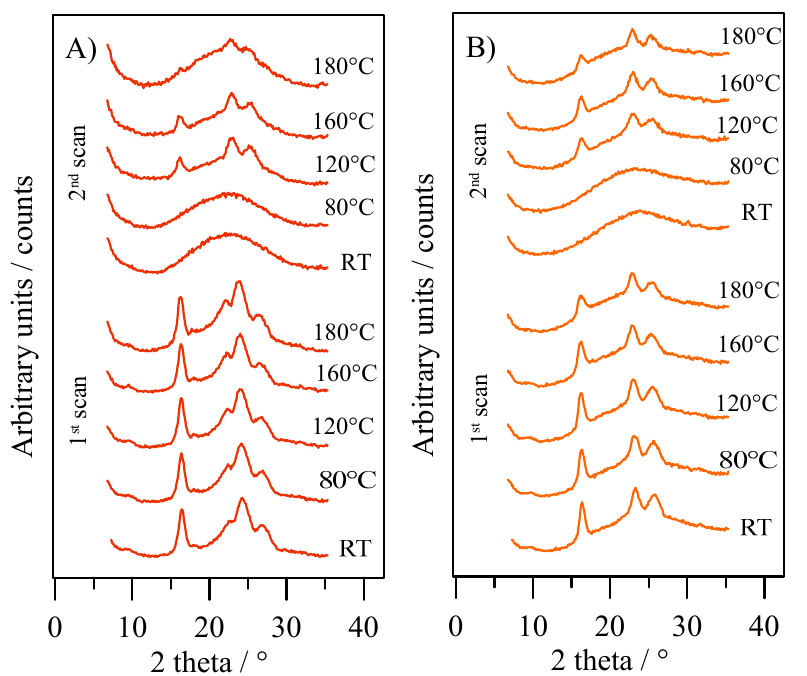
Figure 7. XRD patterns collected in situ at the indicated temperatures for PPTF powder ( A ) and PPTF film ( B ).